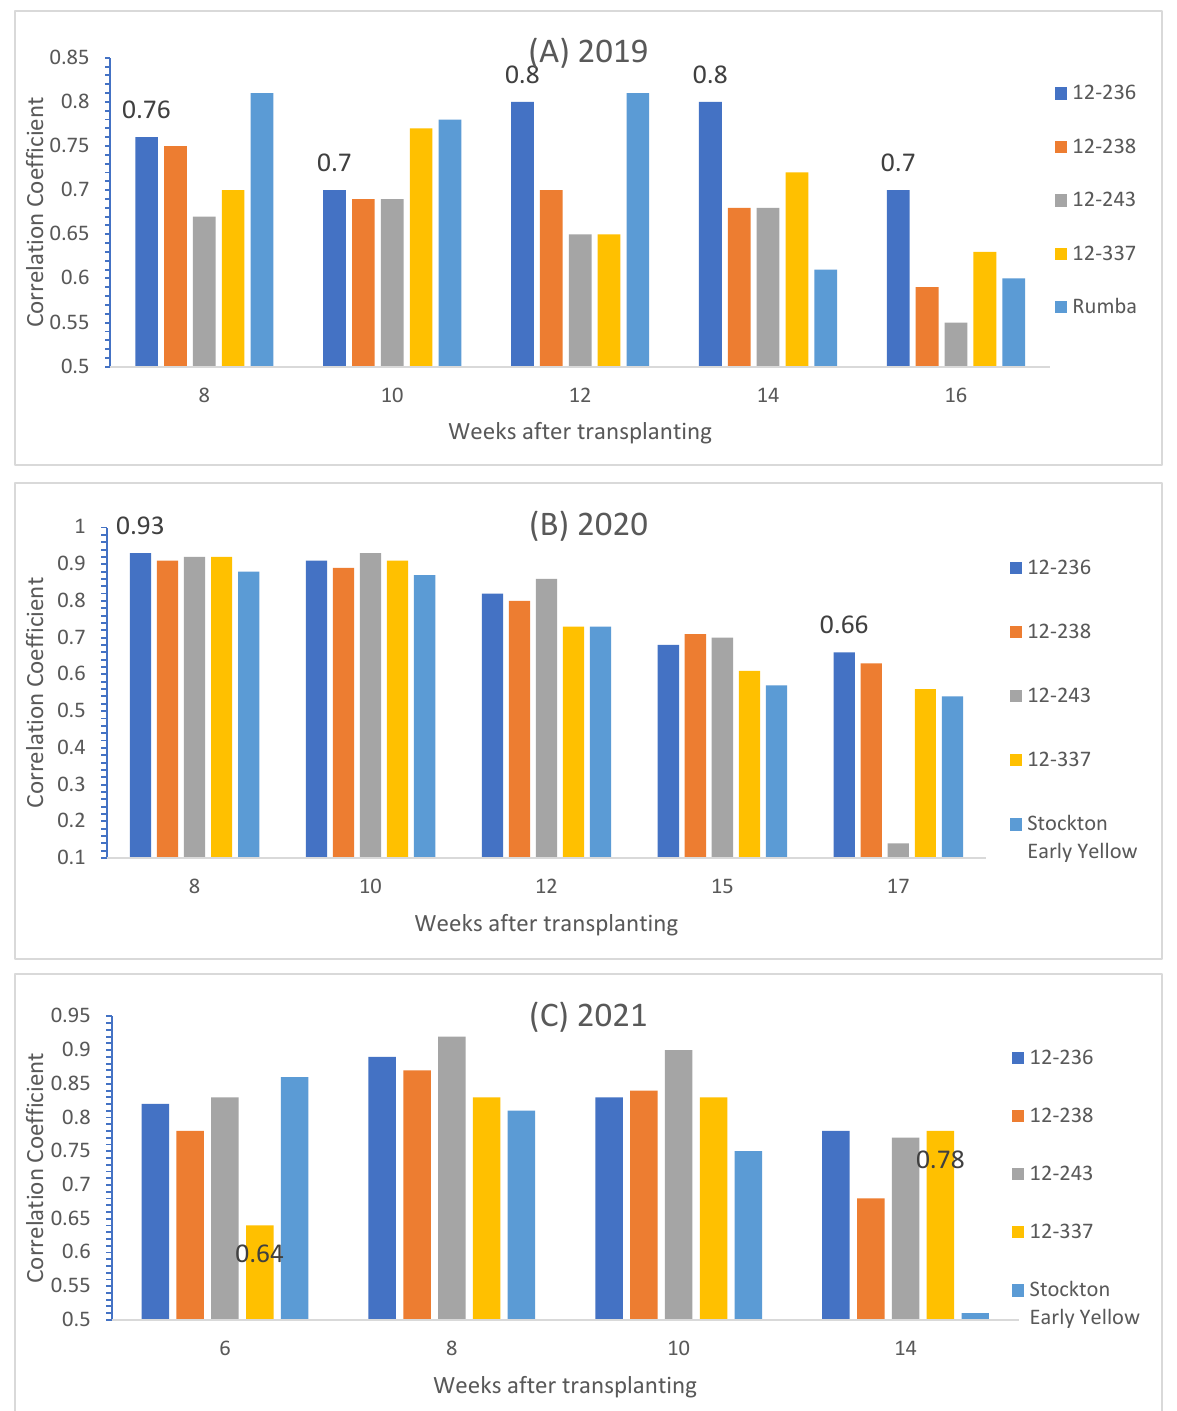
Figure 2. Correlations between sheath diameter and plant height through the growing season and for entries on per plant basis in ( A ) 2019, ( B ) 2020 and ( C ) 2021, at p < 0.001 significance level. In 2019, NMSU 12-236 exhibited a sharp decrease in correlation between leaf number and sheath diameter by 12 WAT (from about 0.7 to 0.3) (Figure 1). This may have been caused by plants of this entry maturing earlier and hence starting to lose leaves at that time [18]. NMSU 12-236 did not exhibit the same drop in correlation coefficient in 2020 and 2021, perhaps because several plants were smaller than others in the beginning of the growing season. This allowed a continued production of larger plants and more leaves by